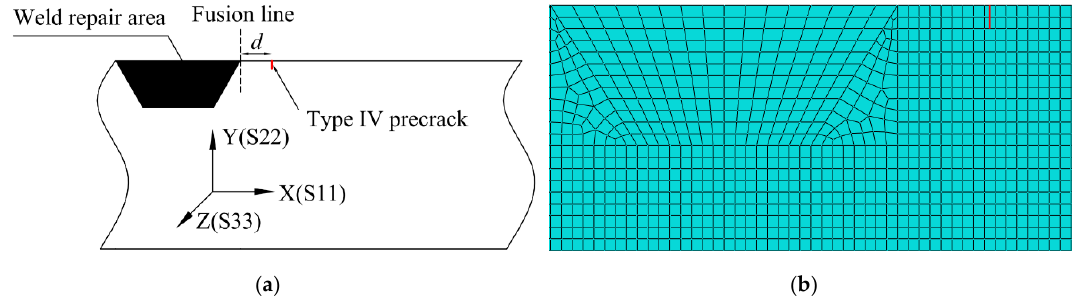
Figure 11. Precrack definition: ( a ) the physical model with a precrack; ( b ) the XFEM model with a precrack.